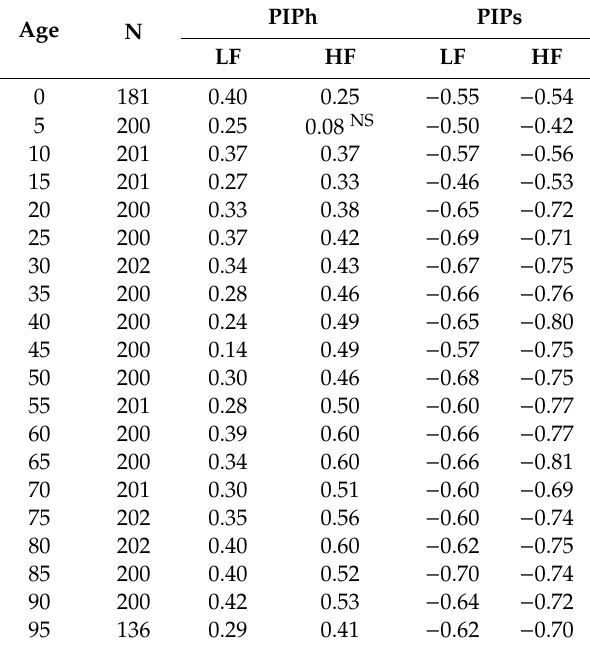
Table 3. Correlation coe ffi cients between HRF and HRV